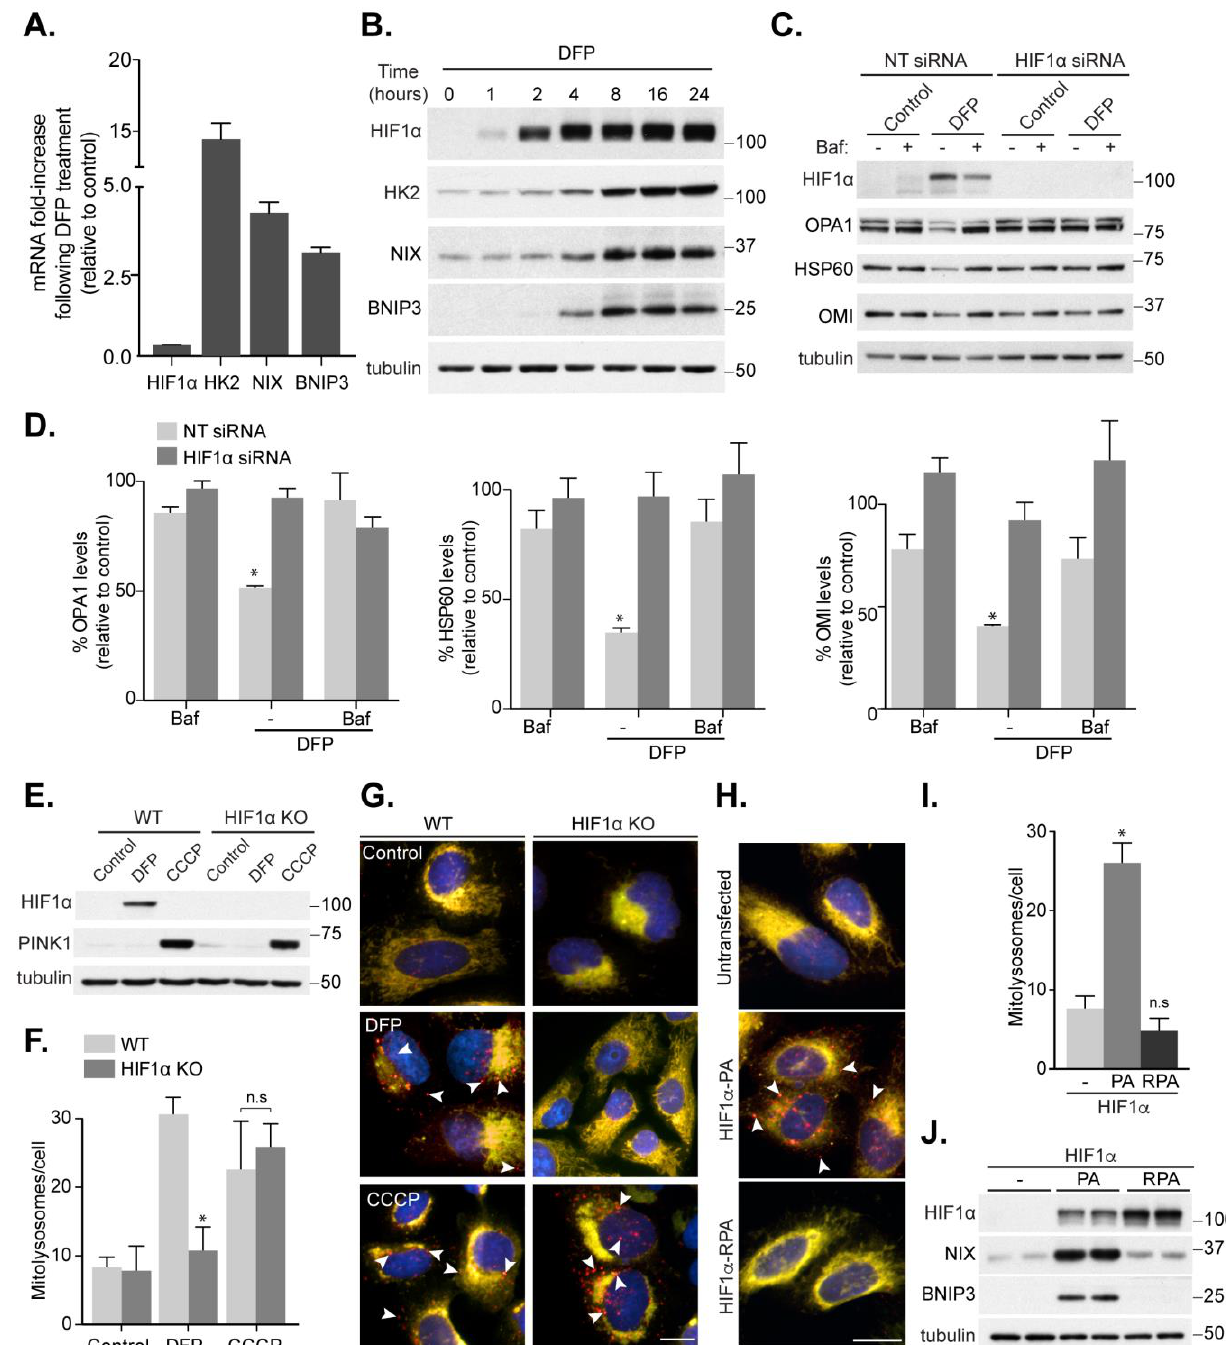
FIGURE 1: HIF1α is essential for mitophagy induced by loss of iron. SH-SY5Y cells were treated with 1 mM DFP for 24 h (A) or the indicated length of time (B) prior to lysis. (C) SH-SY5Y cells were transfected with non- targeting (NT) siRNA or siRNA targeting HIF1α. After 48 h of knockdown, cells were treated with 1 mM DFP for an additional 24 h with/without the addition of 50 nM bafilomycin A1 (Baf A1) for the final 16 h of treatment. (D) Quantitation from (C) of mitochondrial proteins relative to control condition. Mitophagy reporter ( mito -QC) WT or HIF1α KO U2OS cells were treated with 1 mM DFP or 20 μM CCCP for 24 h prior to lysis (E) or fixation (F-G) . (F) Quantitation from (G) of mean mitolysosome (red-only) puncta per cell as indicated. (H) Representative images from mito -QC U2OS cells in combination with either Flag- HIF1α P402A/P5 64A (PA) or Flag- HIF1α P402A/P564A/R27G (RPA). (I) Quantitation from (H) of mean mitolysosome puncta per cell as indicat- ed. (J) Control U2OS cells or U2OS cells stably expressing either Flag- HIF1α -PA or Flag- HIF1α -RPA were lysed and subject to immunoblot analy- sis. All quantitative data are mean ± SEM from 3 independent experiments. Arrows highlight mitolysosomes. Scale bar, 10 μm. * P < 0.05, n.s, not